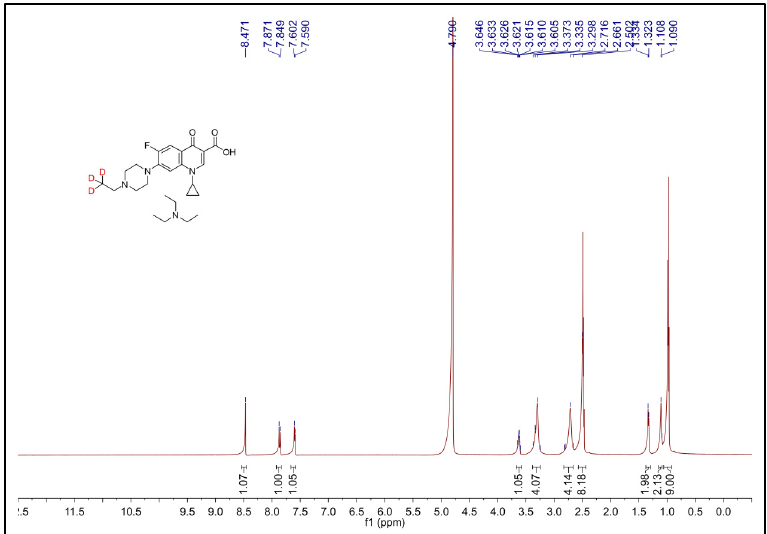
Figure 3. 1 H NMR spectrum of ENR- d 3 .